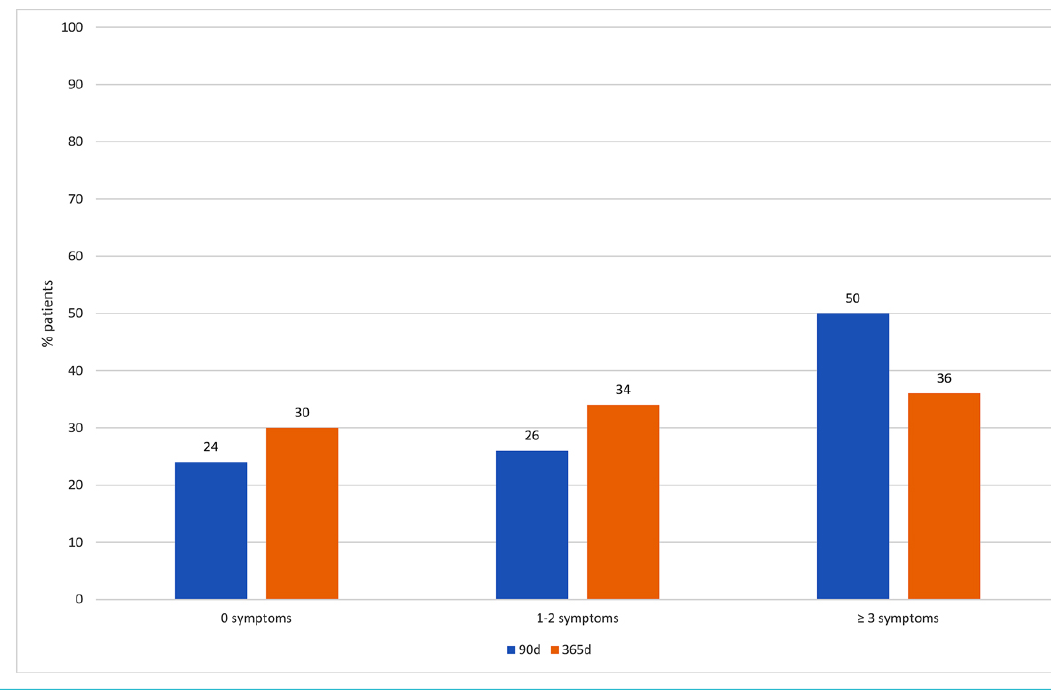
Figure 2: Number of persistent symptoms 90 and 365 days after